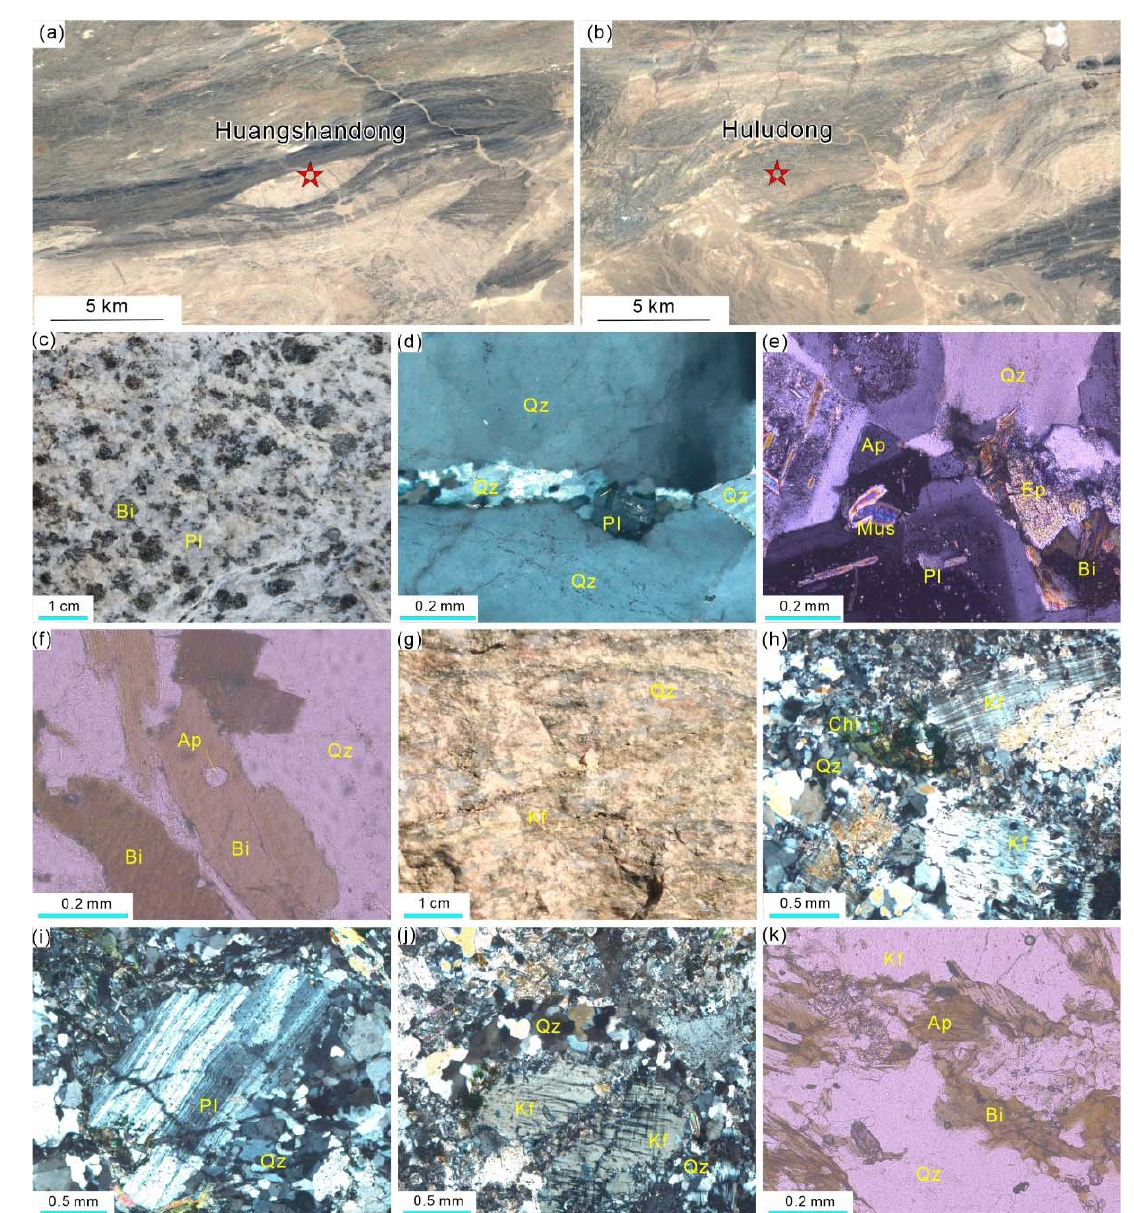
Figure 2. Typical features of the HSG and HDG. ( a ) The lenticular HSG. ( b ) The gneissic HDG. ( c ) Porphyry granodiorite of HSG. ( d ) Recrystallized quartz from HSG showing undulatory extinction in perpendicular polarized light. ( e ) Subhedral granular apatite from HSG associated with microcline with perpendicular polarized light. ( f ) Granular apatite from HSG associated with biotite in plane polarized light. ( g ) Weakly oriented gneissic monzogranite of HDG. ( h ) Chlorite alteration and metasomatized K ‐ feldspar from HDG with perpendicular polarized light. ( i ) Deformed plagioclase from HDG surrounded by wave extinction quartz with perpendicular polarized light. ( j ) Quartz with undulatory extinction around plagioclase with perpendicular polarized light. ( k ) Subhedral granular apatite in plane polarized light. Mineral abbreviations: Q—quartz; Pl—plagioclase; Kf—K—feldspar; Bi—biotite; Mus—muscovite; Ep—epidote; Chl—chlorite; Ap—apatite.